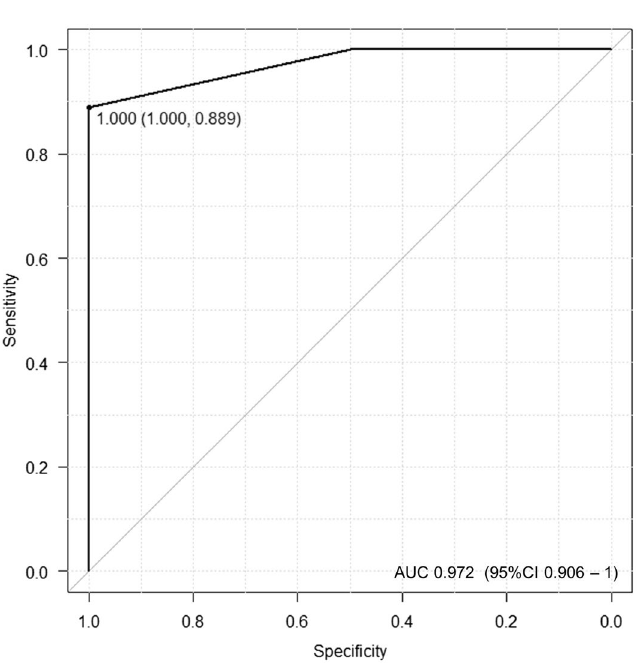
Figure 6. Receiver operating characteristic curve for predicting the response to ICI